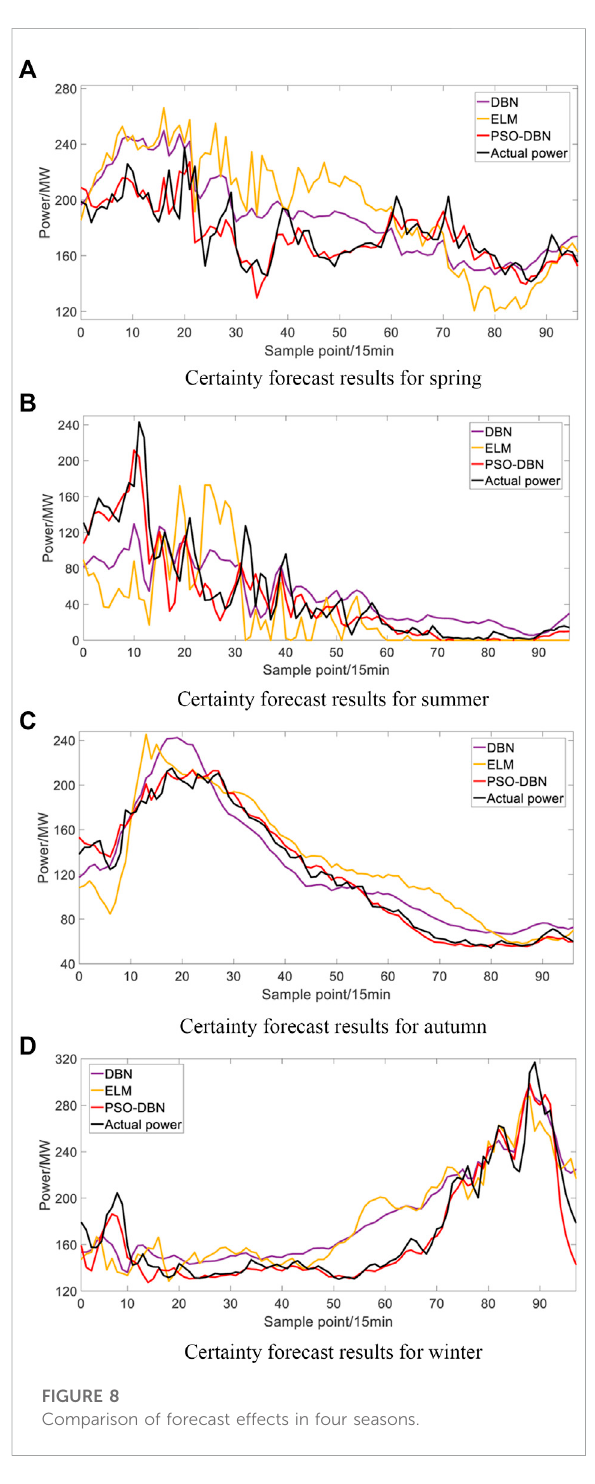
FIGURE 8 Comparison of forecast effects in four